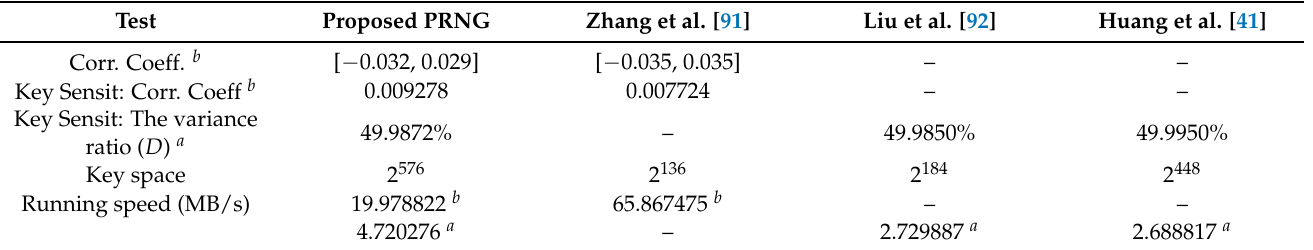
Table 7. Comparison analysis of the proposed PRNG against similar